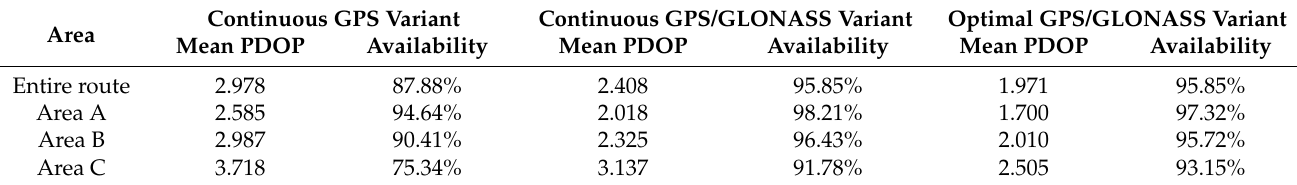
Table 3. The average values of the PDOP, obtained during simulation tests for the first measurement campaign. Continuous GPS Variant Area